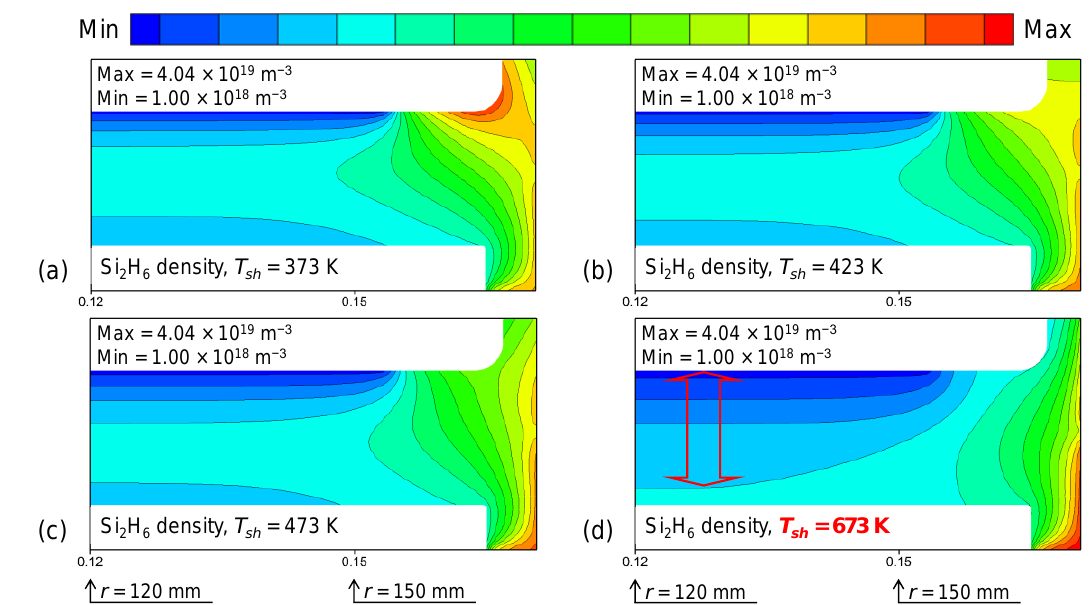
Figure 5. Effects of the showerhead temperature ( T sh ) on the spatial distribution of the source gas. Spatial variations in the Si 2 H 6 density distributions (m −3 ) for ( a ) Case 2 ( T sh = 373 K), ( b ) Case 3 ( T sh = 423 K), ( c ) Case 4 ( T sh = 473 K), and ( d ) Case 5 ( T sh = 673 K) for r ≥ 120 mm. The profiles are radially uniform for r < 120